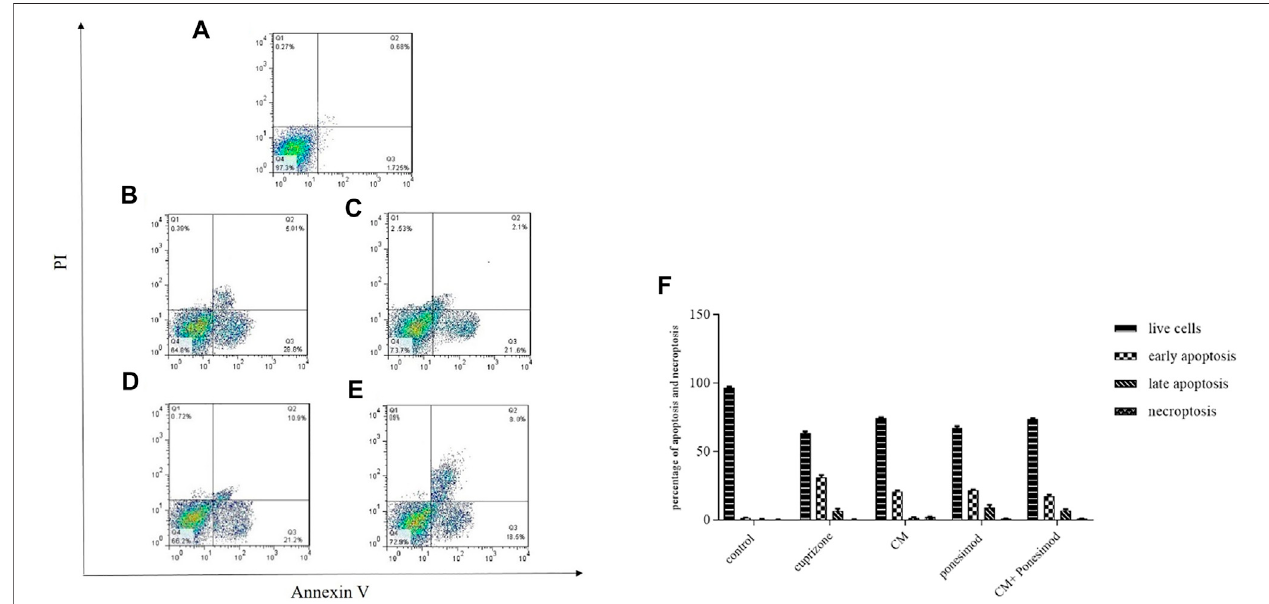
FIGURE 6 | Flow cytometry analysis of annexin-V surface Annexin V to determine apoptotic cells (A) : control, (B) : cuprizone, (C) : CM, (D) : ponesimod, (E) : CM + ponesimod where Q1: PI + /Annexin V − indicates necroptosis; Q2: PI + /Annexin V + shows late apoptosis and Q3: PI − /Annexin V + indicates early apoptosis, Q4: live cells. (F) : The Flow cytometry analysis graph that shows the percentages of live cells, early apoptosis, late apoptosis, and necroptosis.